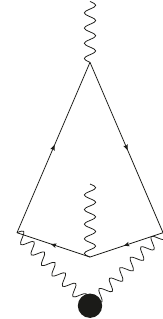
Figure 1 . Diagrams contributing to the anomalous dimension of σ∂ s σ to order 1 /N